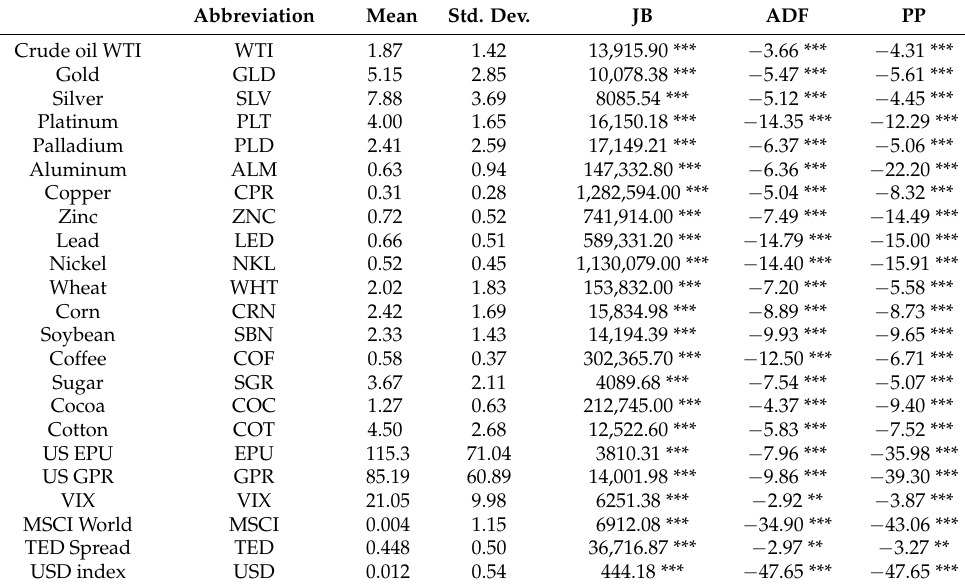
Table 1. Descriptive statistics for commodity uncertainties and global